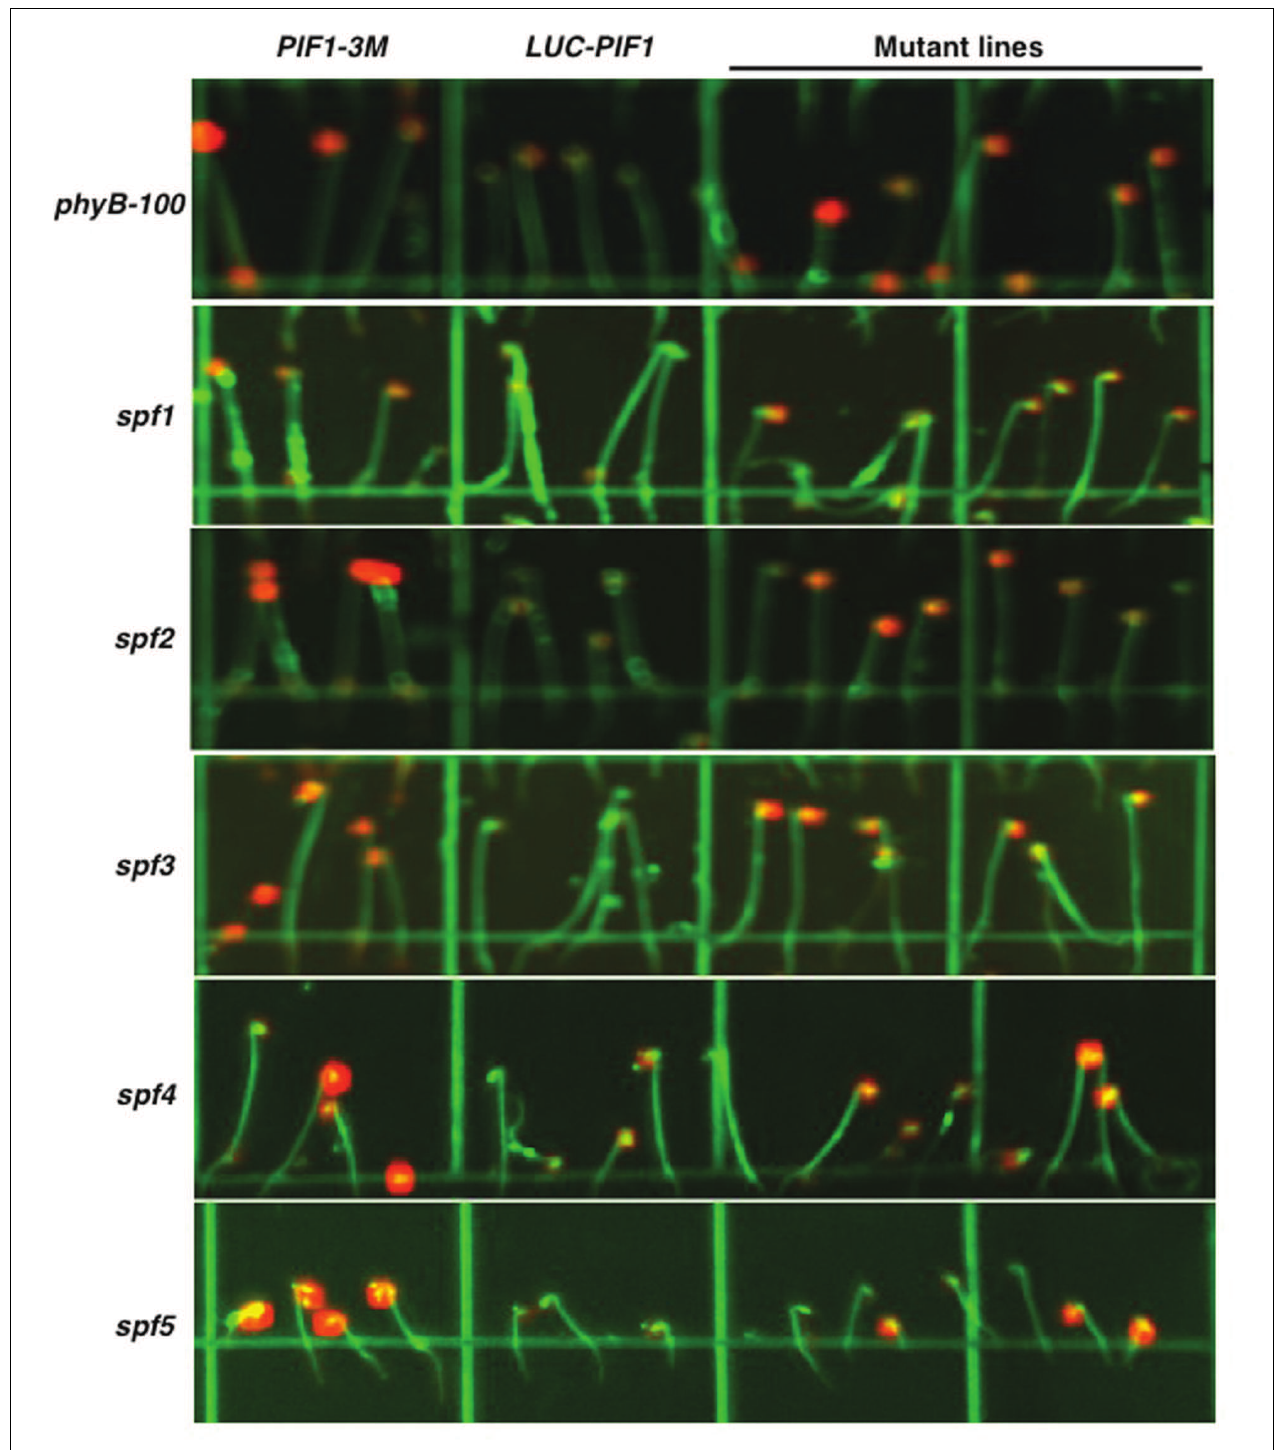
FIGURE 3 | Luciferase imaging to identify five best lines showing stable LUC-PIF1 fusion protein level. Representative images for various mutant lines are shown along with controls. Seeds were plated on 100 mm × 100 mm × 15 mm square plates with MS media and imbibed at 4 ◦ C in darkness for 4 days. The plates were exposed to 3 h of continuous white light to stimulate germination and then kept in the dark at 21 ◦ C for 3 days. The luciferase images were taken after 15 min of white light exposure followed by 5 min treatment with 1 mM Luciferin plus 0.01% Triton X-100. Each plate contains PIF1-3M as a positive control and LUC-PIF1 as a negative control. spf5 is heterozygous in this